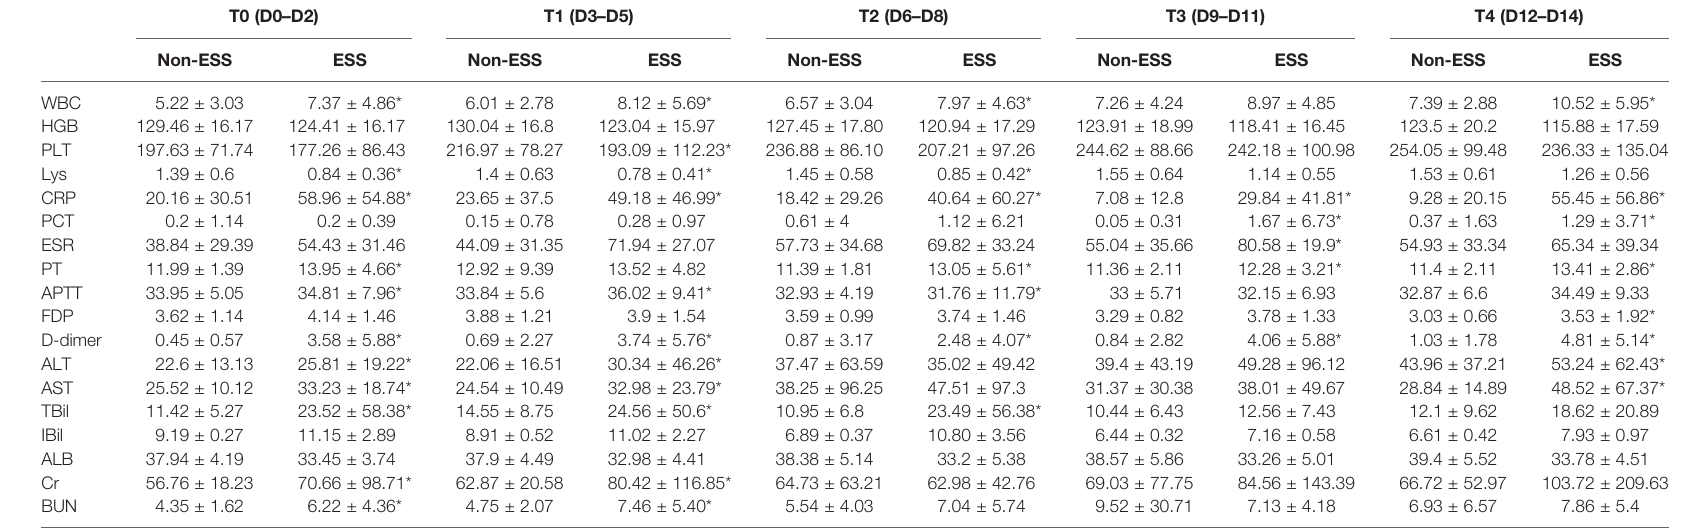
TABLE 3 | Laboratory fi ndings of patients with ESS and non-ESS at different time points after